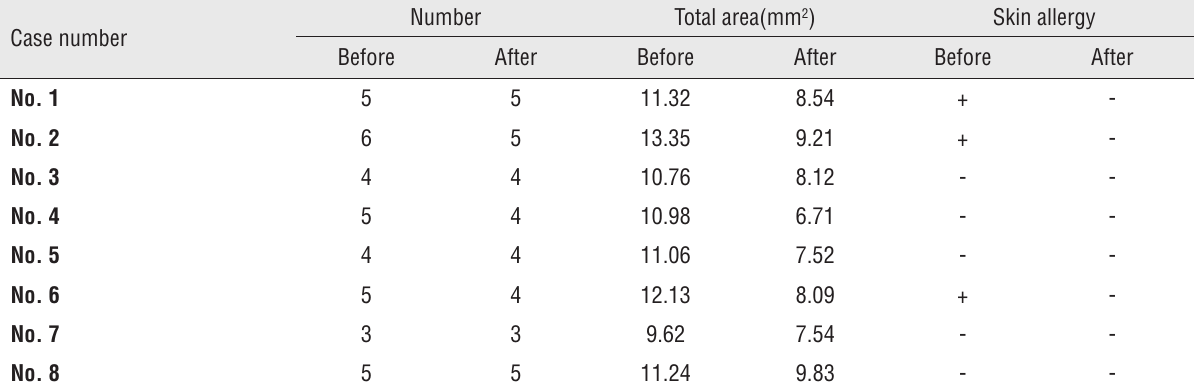
Table 1 - comparison of skin allergy, number and size of polyps before and after the application of a high barrier plastic wrap. Case number